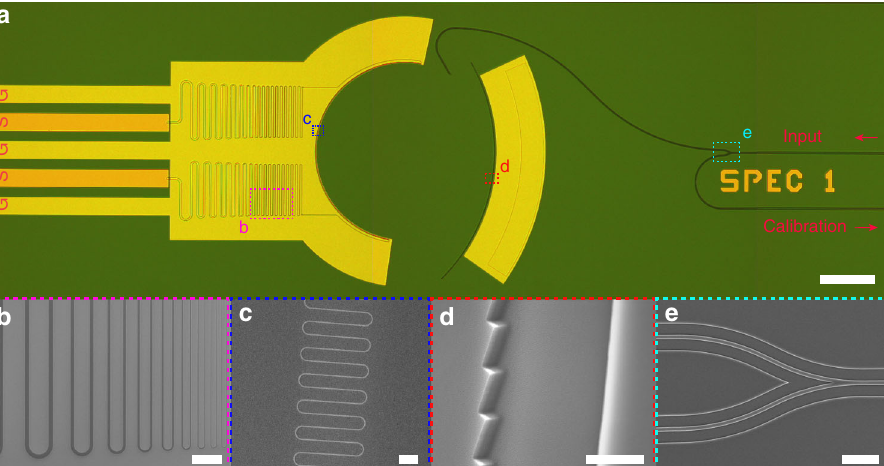
Fig. 2 Broadband device images. a Overview optical micrograph image of the device. The input waveguide is fi rst split into two waveguides, one to feed photons to the spectrometer, the other used for power calibration and monitoring the return power during the fi ber-to-chip alignment. At the ends of the impedance tapers, the microstrip lines are converted to coplanar waveguides (CPWs) to match the modes of ground-signal-ground (GSG) RF probes. The yellow color represents Al and AlO x beneath, while the signal pads in orange color are made of gold (Au). Scale bar, 250 µ m. b Close-up SEM image of the impedance taper. Both ends of the nanowire detector are tapered from 60 nm to microns width to preserve the fast-rising edges of photon-excited microwave pulses. Scale bar, 10 µ m. c Close-up SEM image of the meander nanowire detector. The nanowire is patterned from 8 nm-thick NbN fi lm. The width, pitch and depth of the nanowire is 60 nm, 700 nm and 3 µ m, respectively. Scale bar, 1. d Angular SEM view of a section of the echelle grating. The pitch of the grating teeth is 0.8 µ m and the blaze angle is 20 degree. Scale bar, 1 µ m. e Expanded SEM view of the waveguide splitter. Scale bar, 10 µ m. The SEM images are taken prior to the deposition of AlO x and Al for Device B (see Supplementary Note